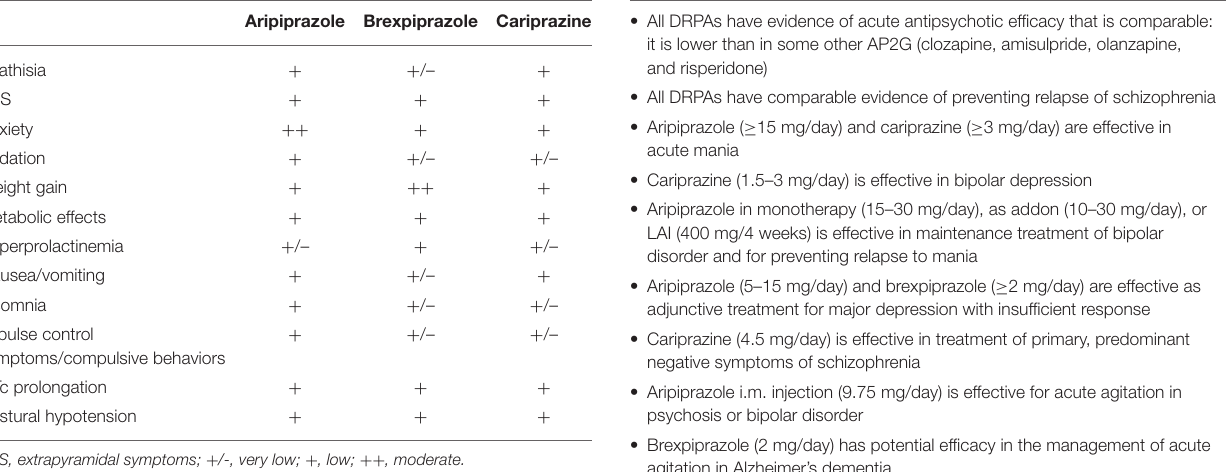
TABLE 6 | Relative risk of the common side effects induced by DRPAs (modified from 4, 76).